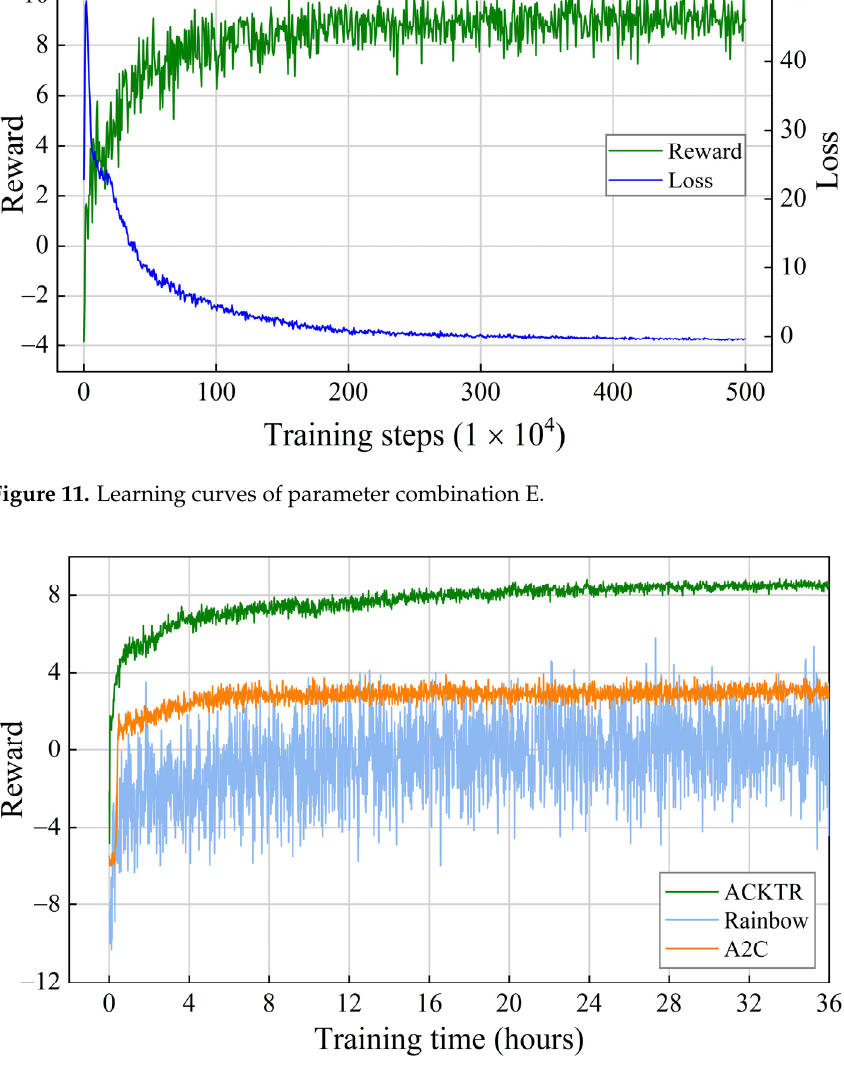
Figure 11. Learning curves of parameter combination E.